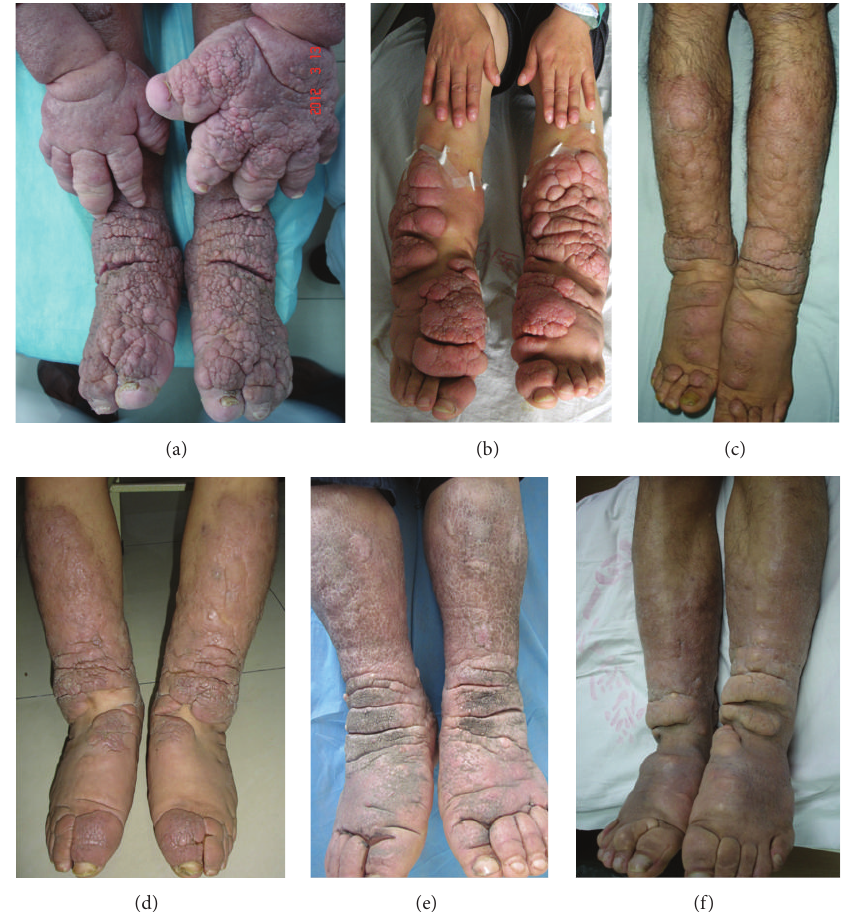
Figure 6: Elephantiasis variant. (a) Elephantiasic legs and hands with hyperpigmented and polypoid appearance. (b) Red, swelling enlargement of lower extremities with nodular, polypoid, fungating, and tumorous appearances from lower one-half of lower legs to toes. (c) Light red, swelling enlargement of lower extremities with nodular, tumorous, and papillary appearance from lower two-thirds of lower legs to toes. (d) Light red, pigmented, nonpitting and swelling enlargement of lower extremities with plaque, papillary, and tumorous appearances fromlowerlegstotoes.(e)Swellingenlargementoflowerextremitieswithhyperpigmented,dry,coarse,papillary,anddeepcreviceappearance looked extremely like legs of elephants. (f) Pigmented, sclerotic enlargement of lower legs to toes with cerebriform and plaque